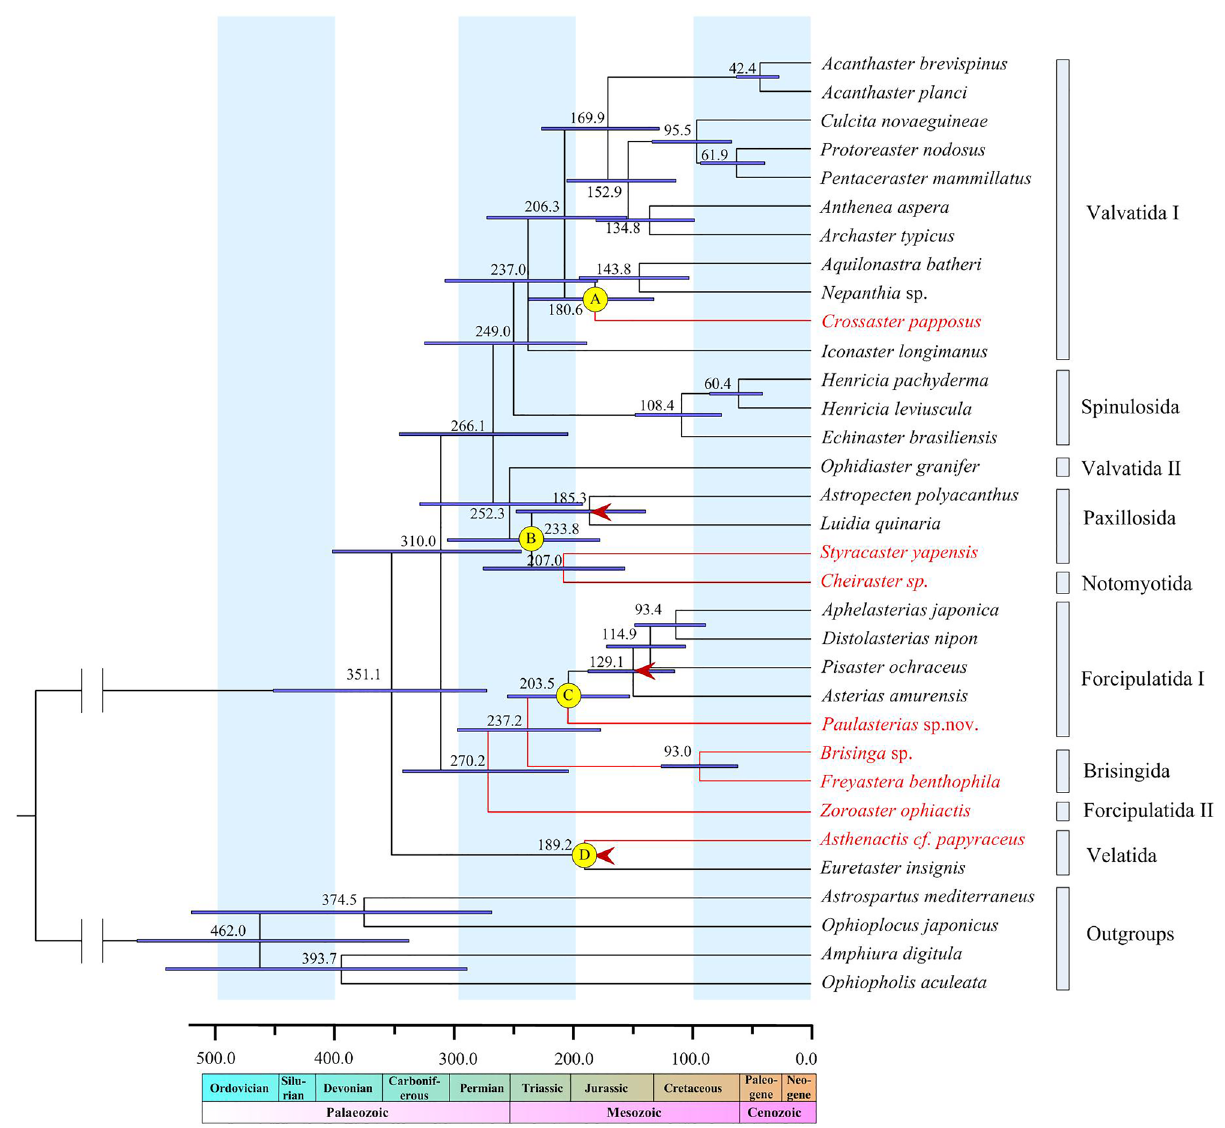
Figure 5. Time-calibrated mitogenomic phylogeny of Asteroidea estimated by the Bayesian relaxed-molecular clock method. The 95% HPD for each node were indicated in light purple bars. Calibrated nodes are indicated by red arrows. The divergence between the deep-sea and shallow-water species were marked by yellow circles (Nodel A, Nodel B, Nodel C and Nodel